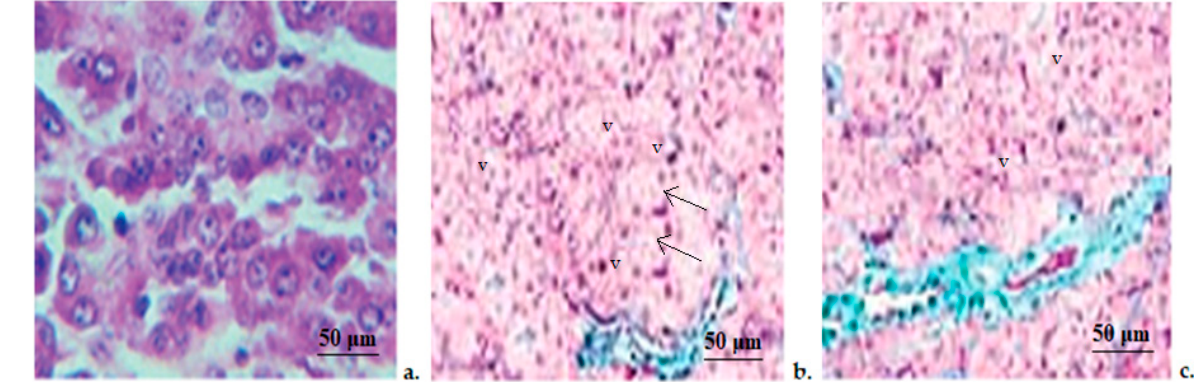
Figure 3. Pancreatic histopathological exam. ( a ) Control group; ( b ) STZ group; ( c ) STZ+Zn group. (arrow—acinar cells, v—vacuoles). Masson trichrome stain × 20.